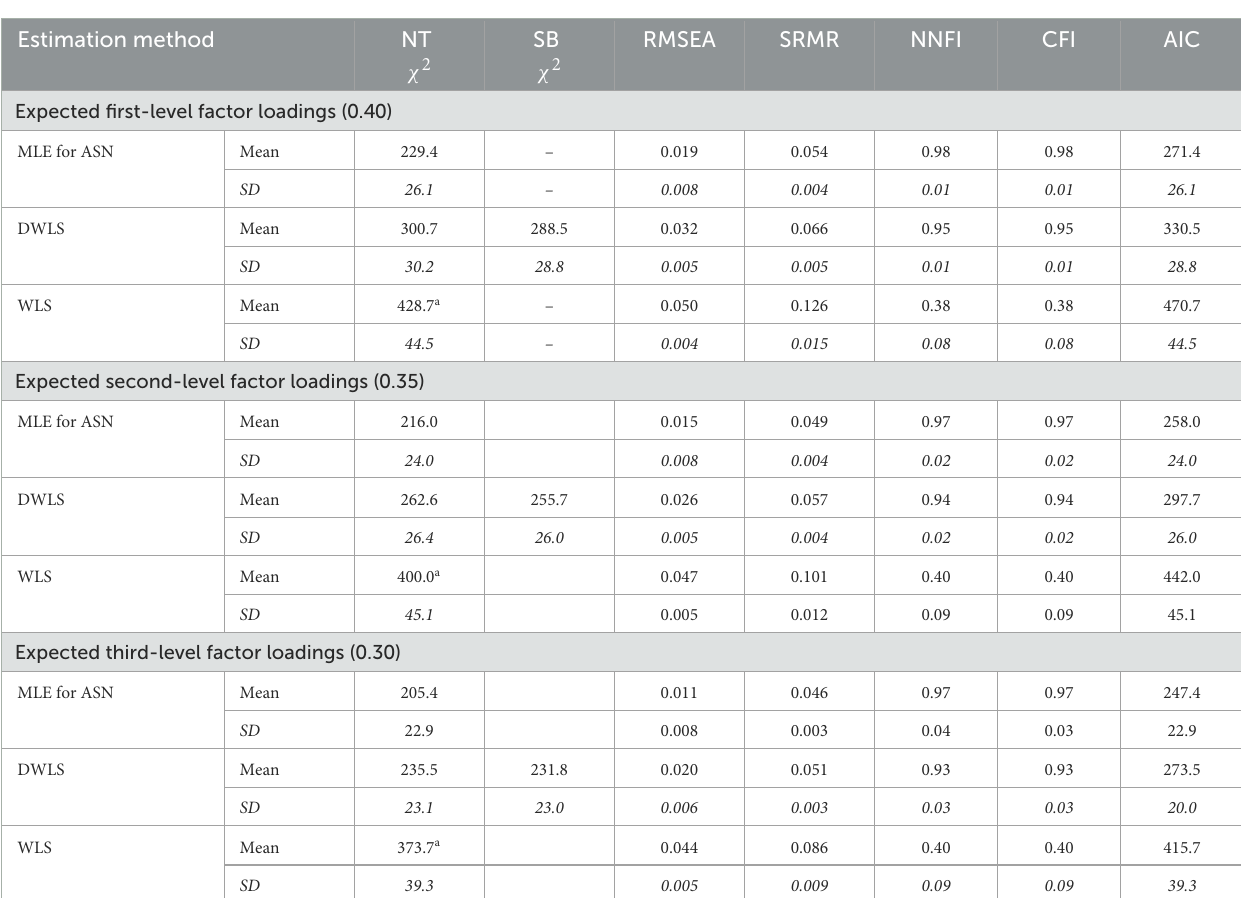
TABLE 3 Mean fit results and SDs (in italics) observed for MLE for ASN, DWLS and WLS in investigating data showing asymmetric non-normality (ASN) ( N = 500). Estimation method